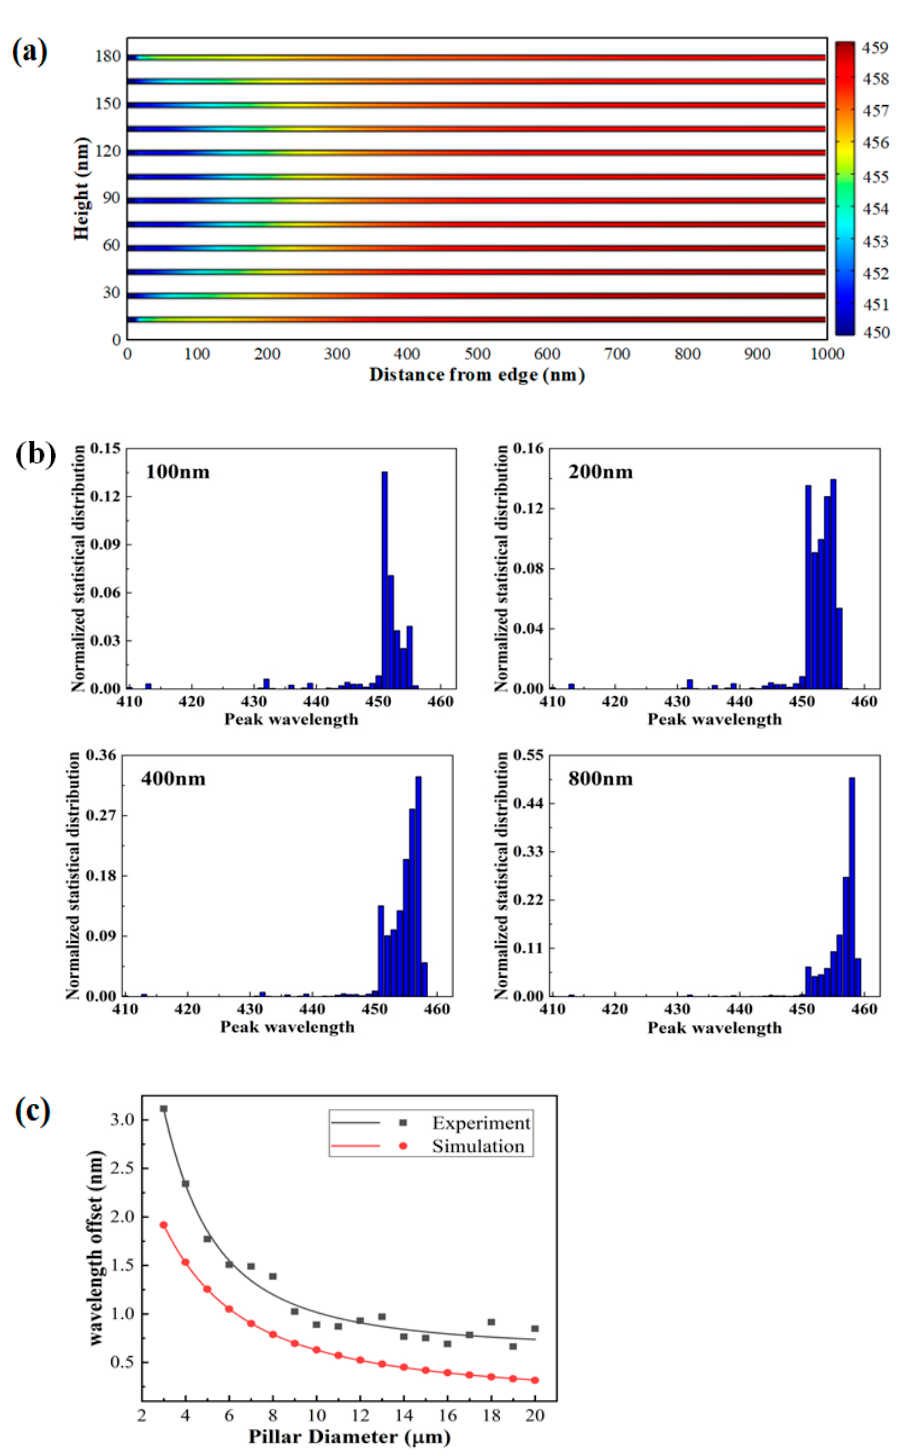
Figure 7. ( a ) The simulated peak wavelength distribution (0–1000 nm) of In 0.25 Ga 0.75 N well layer with a diameter of 20 µ m; ( b ) the intensity of peak wavelengths in 12 pairs of wells in the radius of 100 nm, 200 nm, 400 nm, 800 nm, starting from the boundary; ( c ) experimental and simulated peak wavelength shift as a function of pillar diameter.